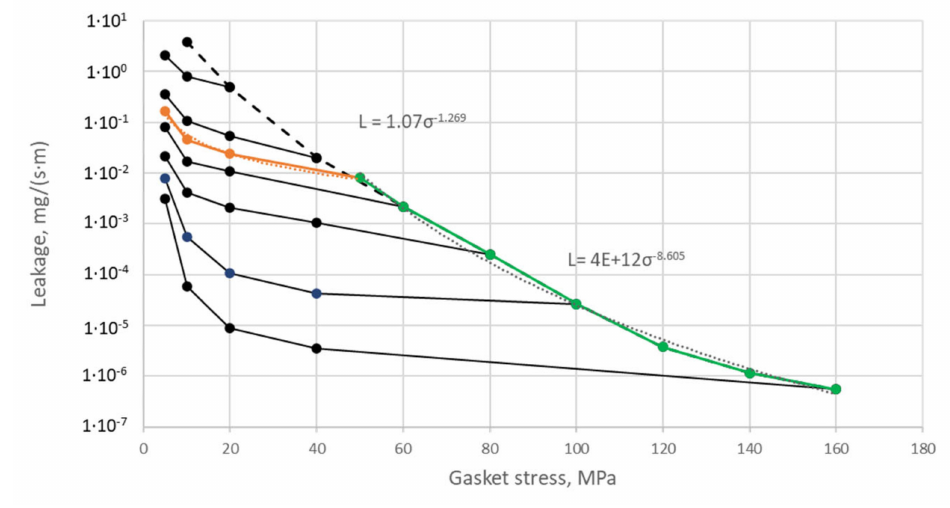
Figure 18. Gasket leakage characteristics.